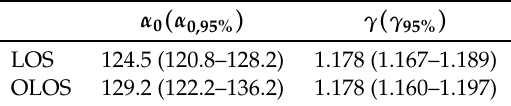
Table 5. Values of α 0 and γ (in